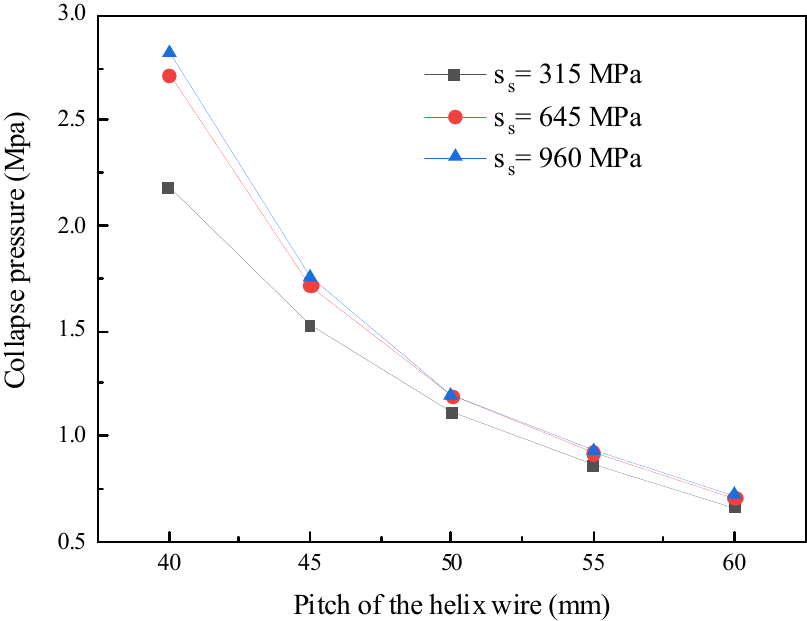
Figure 14. Pressure capacity vs. pitches of helix wire for submarine hose with different yield strength.